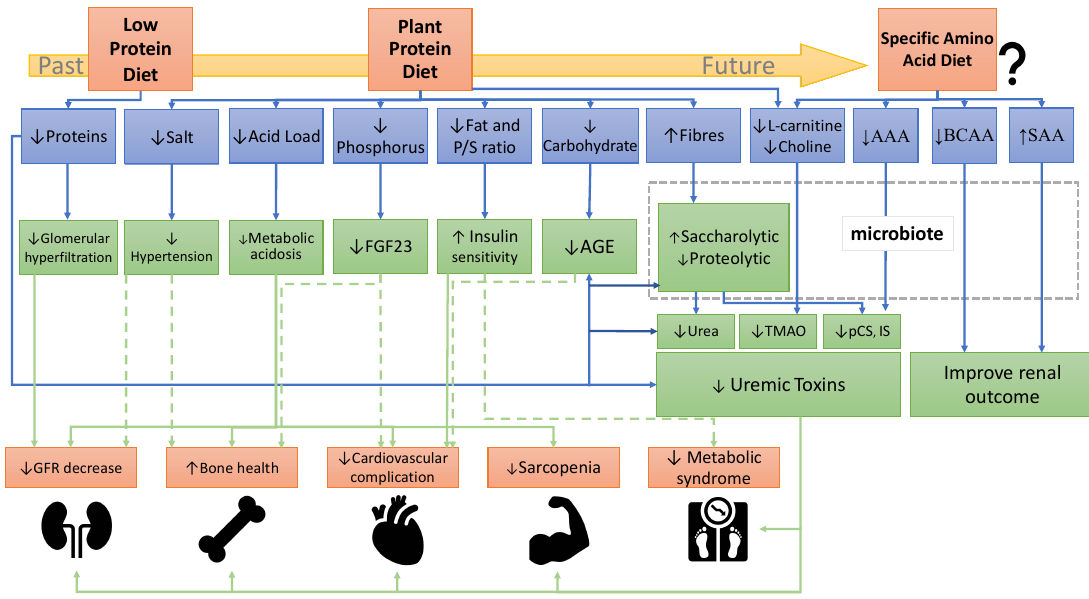
Figure 1. Recommendation evolution of a dietary protein in the prevention and treatment of CKD. Abbreviations: AAA, aromatic amino acids; AGE, advanced glycation end-products; BCAA, branched-chain amino acids; FGF23, fibroblast growth factor 23; GFR, Glomerular filtration rate; IS, indoxyl sulfate; pCS, p-cresyl sulfate; P / S ratio FA, polyunsaturated / saturated ratio of fatty acids; SAA, sulfur-containing amino acids; TMAO, trimethylamine-N-oxide.